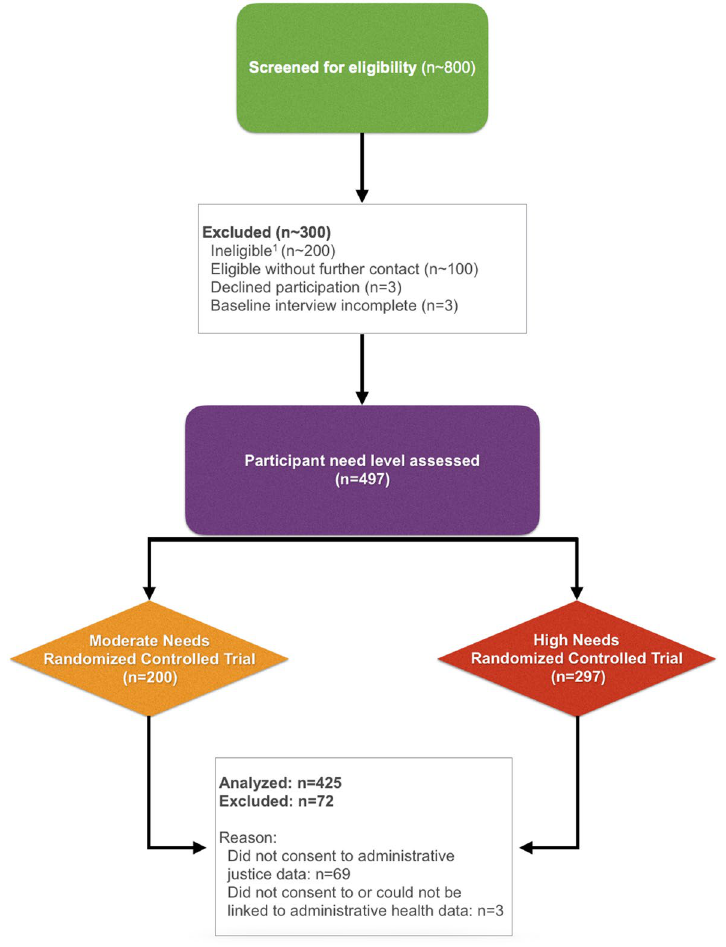
Figure 2. Participant flow-through. 1 About 100 participants were ineligible after telephone screening, and 94 participants after in-person